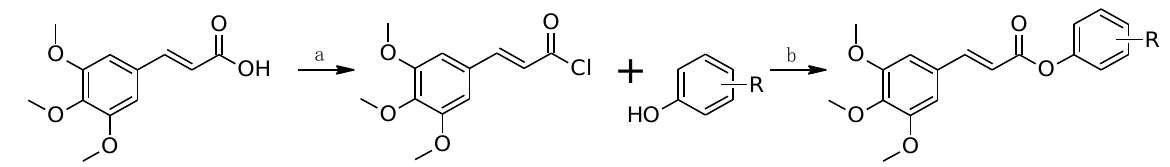
Scheme 1. Synthesis of aryl (2 E )-3-(3,4,5-trimethoxyphenyl)prop-2-enoates 1 – 12 . Reagents and conditions: a: SOCl 2 , dry toluene, reflux 1 h; b: Et 3 N, dry toluene, reflux 1 h.